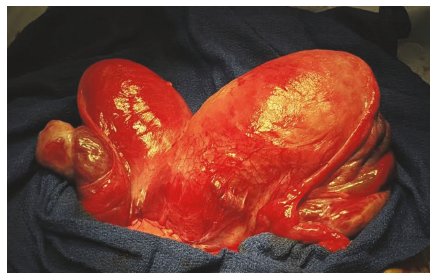
Figure 2: Intraoperative finding of bicornuate uterus (right hemi- uterus on the left side of image, left hemiuterus on right side of image).